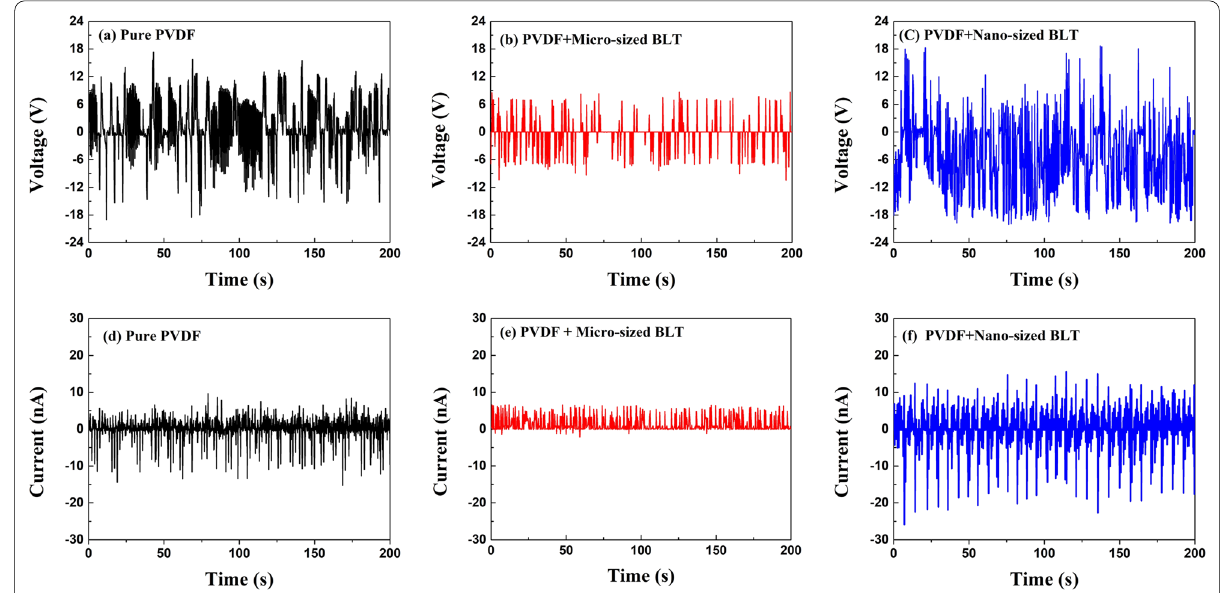
Fig. 7 Open-circuit voltage and the current generation of pure PVDF and PVDF/Powder composites during bending connected to IV solution